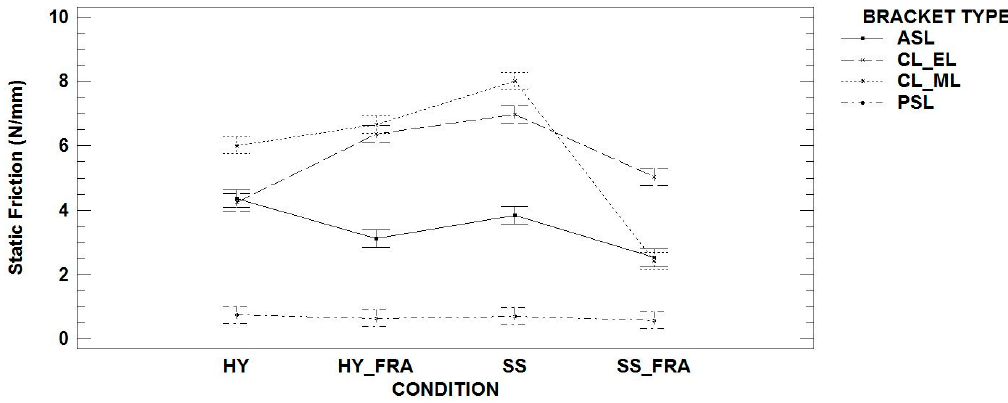
Figure 1. Comparison among different studied brackets/conditions. Table 5. Static friction values using stainless steel wire (SS). The letters show significance statistical differences.